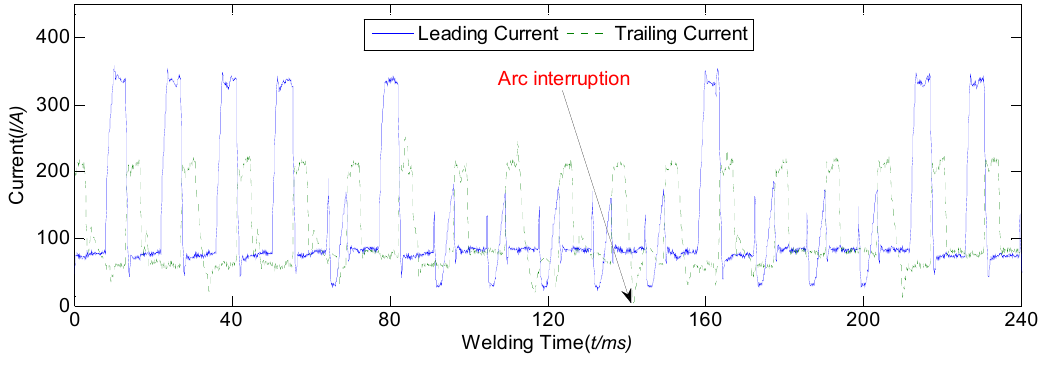
Figure 5. Current waveform of experiment 1.